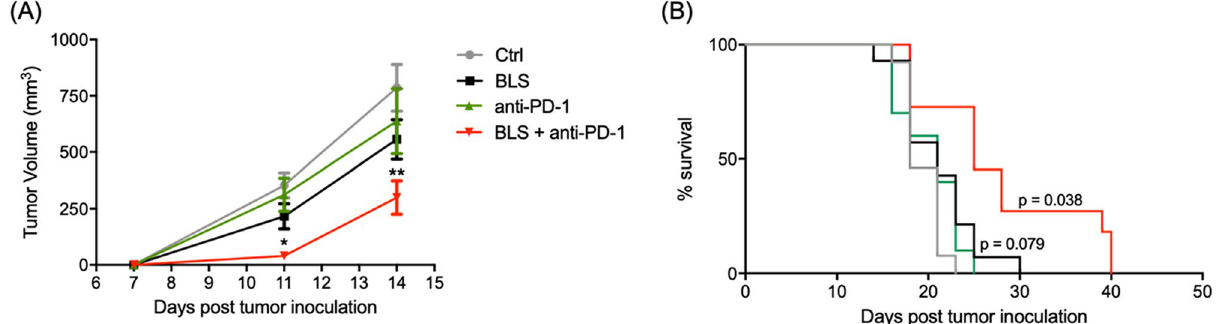
Figure 7. BLS treatment overcomes resistance to anti-PD-1 blockade. B16 cells were inoculated in C57BL/6J mice. At day 2, 200 μg of BLS or PBS (Ctrl and anti-PD-1) were administered s.c., and at days 5, 8 and 11, 200 µg of anti-PD-1 or PBS were i.p. inoculated. Tumor growth ( A ) and mice survival ( B ) were followed every 2–3 days and tumor volume was estimated as 0.5 × (length × width 2 ). Results from two independent experiments were pooled (n = 7 mice per group per experiment). *p < 0.05; **p <